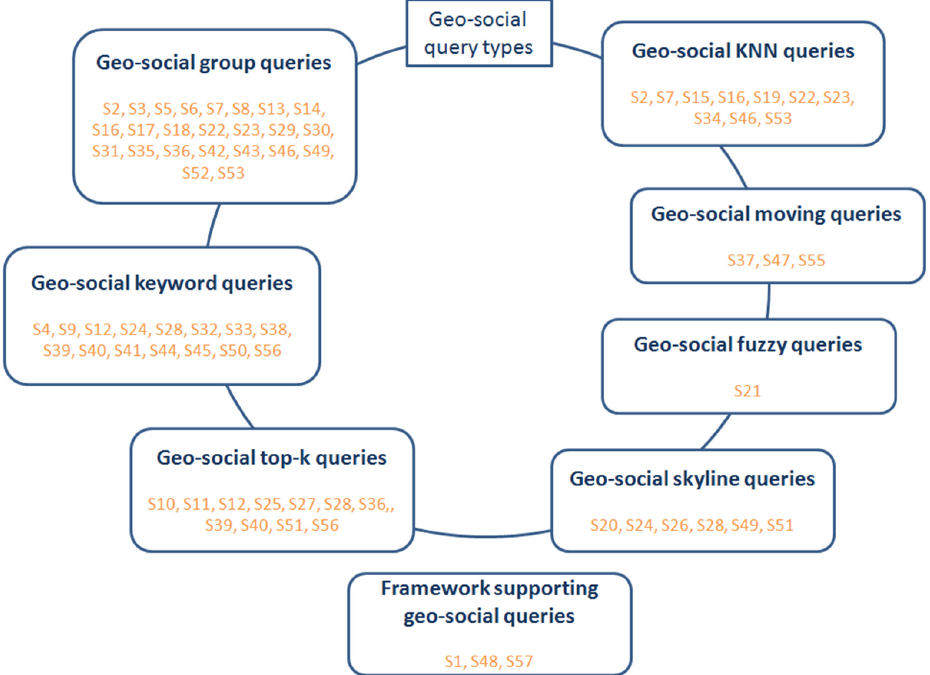
Figure 5. Categories of geosocial queries identified by analysing the surveyed studies, along with the IDs of the studies (defined in Table 4) belonging to each category.